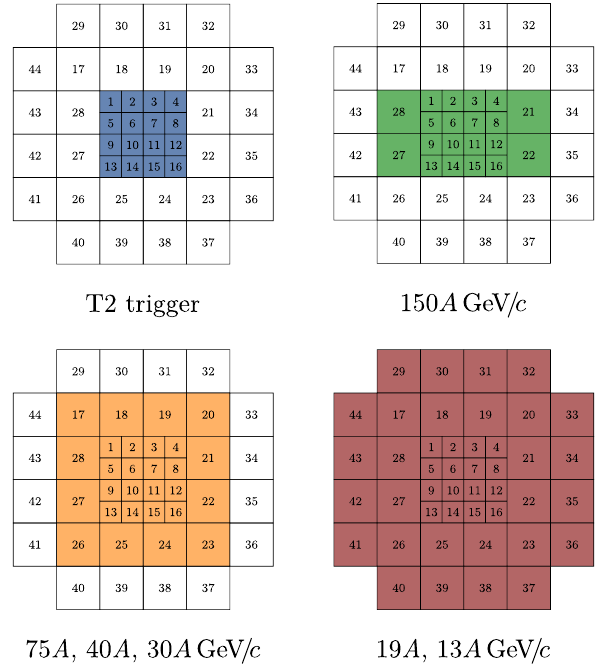
Fig. 2 Schematic diagrams indicating by shading the PSD modules usedintheonlineandofflineeventselection.Thetriggerisderivedfrom theenergyinthecentral16modules(1–16)inbluecolor.Determination ofthePSDenergy E PSD usesthegreen(150 A GeV / c ),orange(75 A ,40 A , 30 A GeV / c ) or all modules (19 A , 13 A GeV / c ) at the respective beam momenta